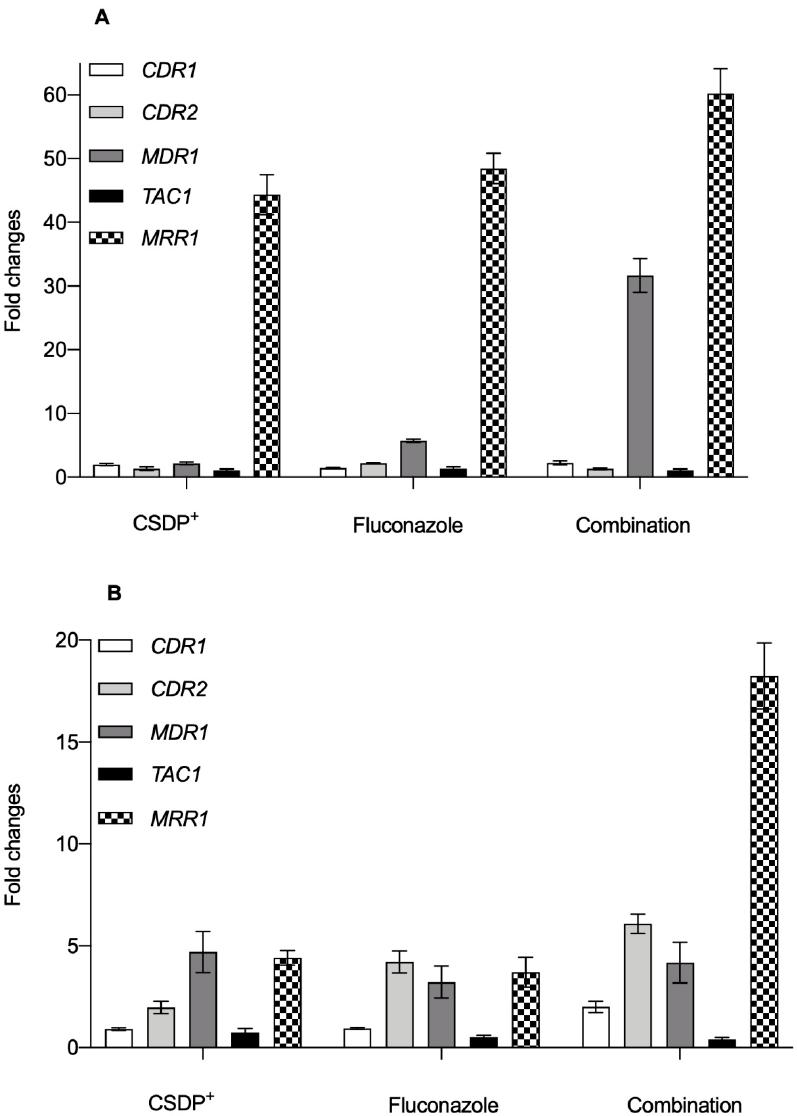
Figure 4. Gene expression in C. albicans wt ( A ) and SV1 ( B ) strain cells. The cells were treated with 2 µ g/mL of CSDP + , 0.125 µ g/mL of fluconazole or combination of both agents (0.25 µ g/mL of CSDP + and 0.0625 µ g/mL of fluconazole). Data are shown as a mean fold change in gene expression relative to control nontreated C. albicans wt or SV1 cells.